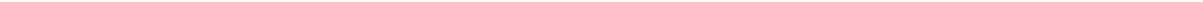
Fig. 3 Stem cells trigger invasion in vivo. a Outline of the experiments in b – k . b Illustration of tissue sampling. Numbers indicate collected tissues. c H&E staining of teratomas to detect three germ layer-differentiation. Scale bars , 100 and 20 μ m. d Immunostaining of teratoma tissue for the detection of mouse cyclophilin A ( upper panels ) or mouse cyclophilin A and human topoisomerase II β ( lower panels ). Nuclei were counterstained with DAPI. The arrrowhead indicates a mouse cell within human teratoma cells. Scale bars , 150 and 20 μ m. e Gelatin zymography of tissue-conditioned medium from Matrigel- or ESC-injected mice to detect secreted MMPs. The gel picture was colour-inverted. The bar indicates vertical cropping. IT, injected tissue. f Immunoblot of tissue lysates for the detection of MMP14. The absence of human cells from non-teratoma tissues and equal loading was veri fi ed by reprobings with human-speci fi c antibodies and Ponceau-S staining. g Immunostaining of teratoma tissue for the detection of MMP14 and human topoisomerase II β . Nuclei were counterstained with DAPI. Arrowheads indicate mouse cells within human teratoma cells. Scale bar , 20 μ m. h Ex vivo transwell invasion assay of indicated tissues. Pictures show the tissues in the top chambers, and the invasive, Calcein-stained cells on the bottom membranes. Data are presented as the fold change of the Matrigel control ( n = 4; mean ± s.d.). Scale bar , 1 mm. i Ex vivo plug invasion assay of indicated tissues. Pictures show the tissues on the top of the plug ( yellow line ) and their invasive outgrowth ( grey line ). Data represent the invasion distance in μ m ( n = 4; mean ± s.d.). #, non-detectable. Scale bar , 400 μ m. j Immunostaining of murine CD31 ( upper left panel ), HS1 ( upper right panel ) and SMA (